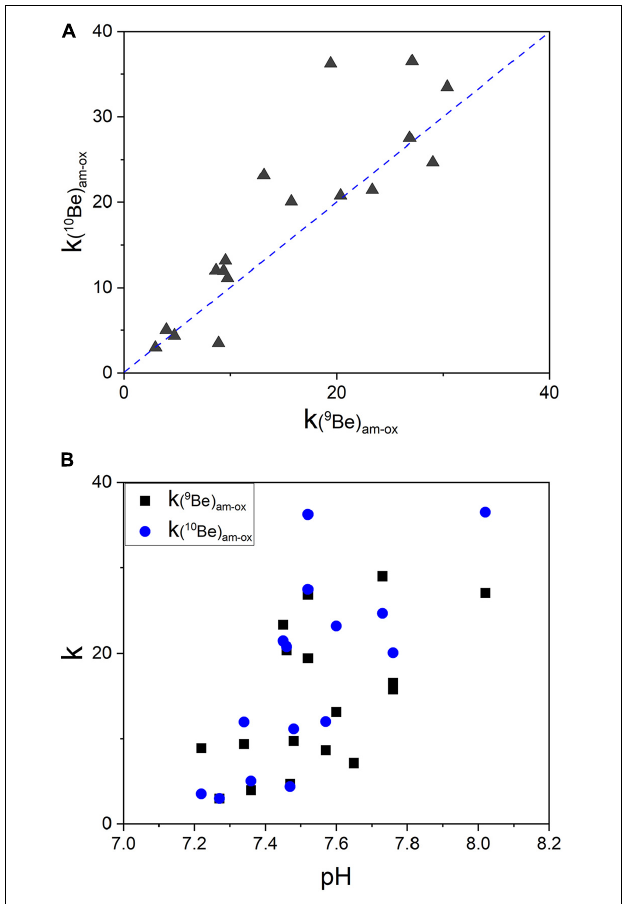
FIGURE 3 | (A) The partition ratio ( k ) of 9 Be and 10 Be between amorphous oxides and dissolved phases. The blue dash line represents 1:1 line. (B) The k -pH plot of both 9 Be (black squares) and 10 Be (blue dots), the data of HM with pH < 7 are not shown. The extremely high values of L3 were excluded in these plots due to suspended load